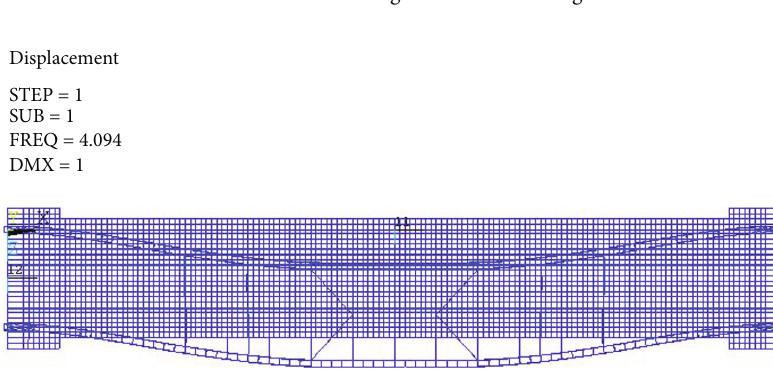
Figure 21: The sixth order buckling mode of arch bridge under case 1.